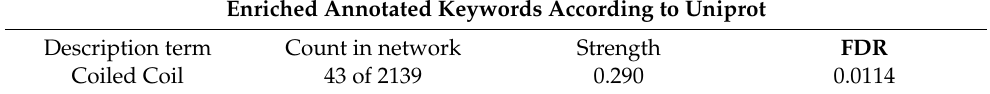
Table 4. Results of the functional enrichment analysis of the network according to Uniprot. The count in network indicates how many proteins in our network are annotated with the term “coiled- coil” of the total number of proteins assigned to the same term. Strength is calculated as log10 (observed/expected) for the number of proteins expected to be annotated with this term in a random network and finally, FDR (false discovery rate) is calculated after multiple testing correction according to Benjamini and Hochberg.